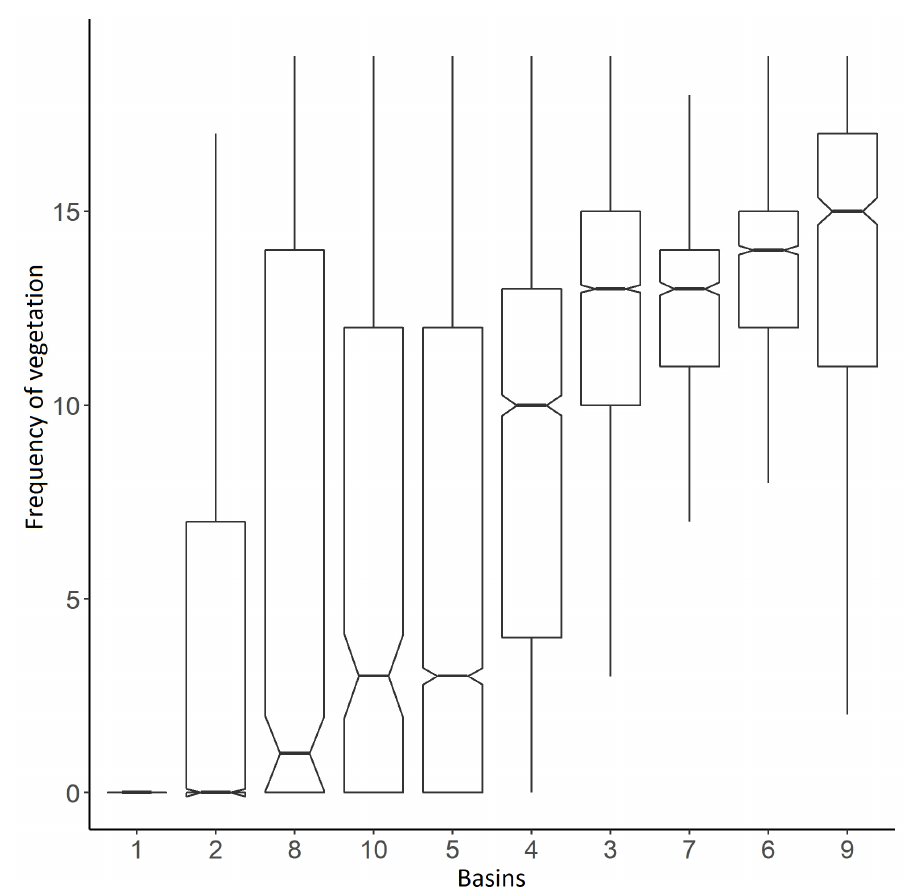
Figure 10. Vegetated frequencies by basins.